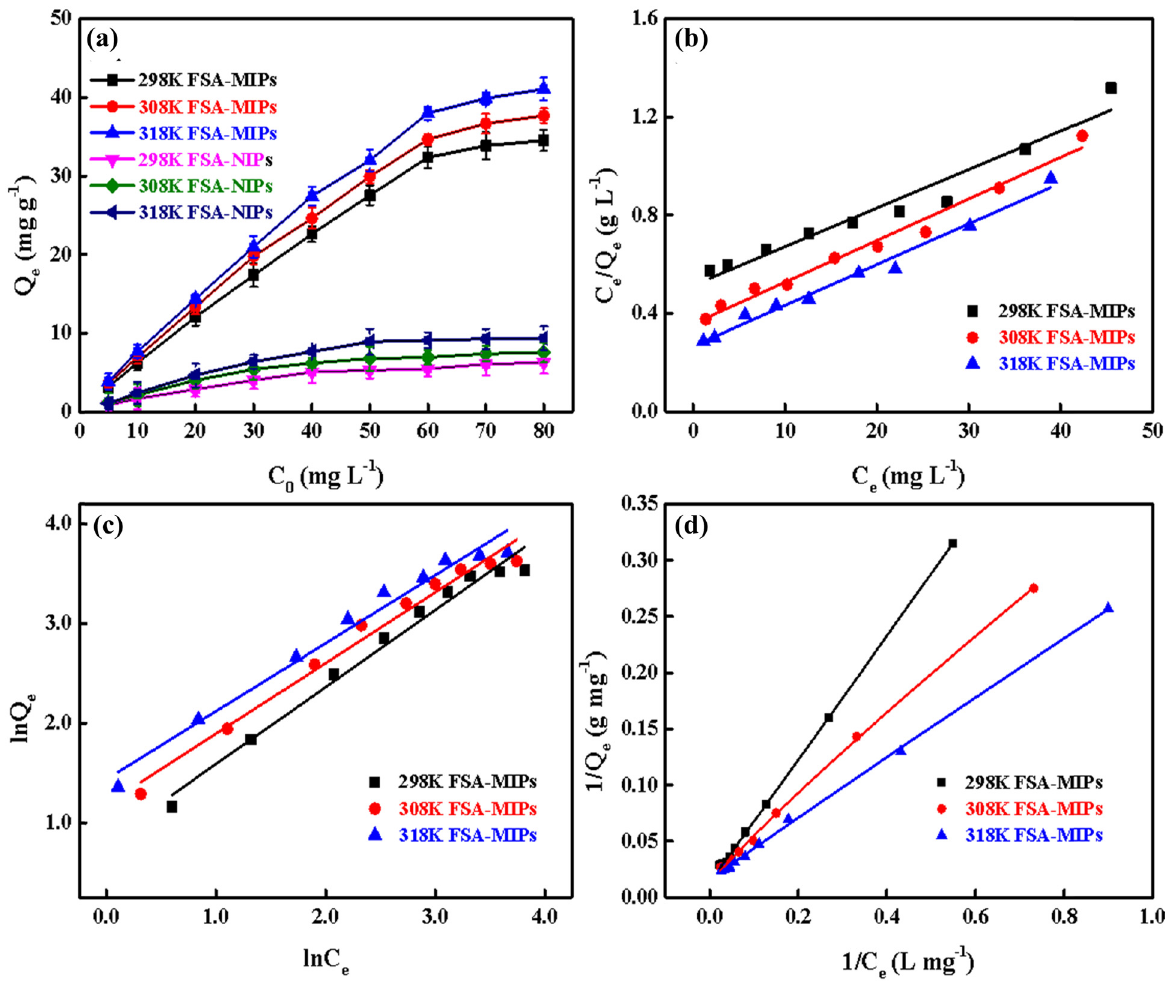
Figure 3: ( a ) Adsorption isotherms of 4 - MMC onto FSA - MIPs and FSA - NIPs at di ff erent temperatures, and the linear fi tting curves of ( b ) Langmuir adsorption model, ( c ) Freundlich adsorption model, and ( d ) slips or Langmuir – Freundlich model of 4 - MMC onto FSA - MIPs at di ff erent